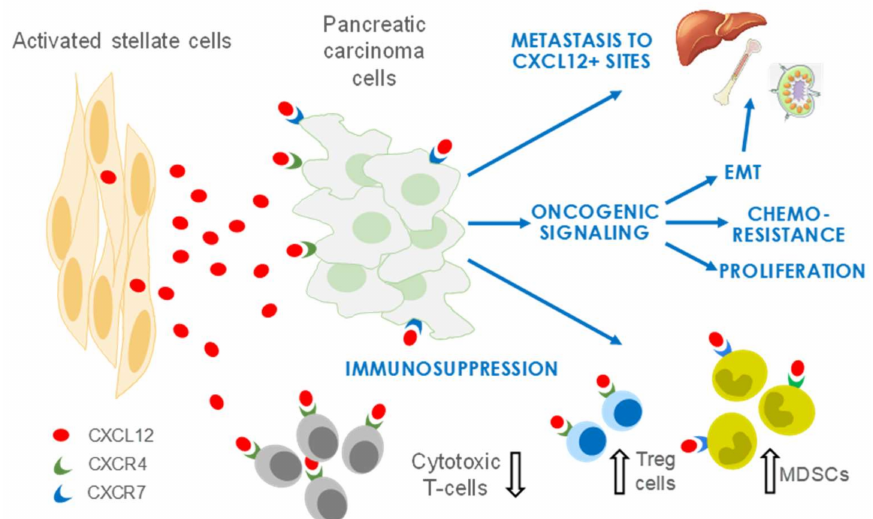
Figure 1. Roles of stroma/stellate cells in PDAC. CXCL12 secreted predominantly by activated stellate cells/CAFs promotes an environment conducive to PDAC growth and metastasis. CXCL12 also has crucial functions in immune evasion and development of resistance to chemotherapies. EMT, epithelial-to-mesenchymal transition; Treg, regulatory T cell; MDSCs, myeloid-derived suppressor